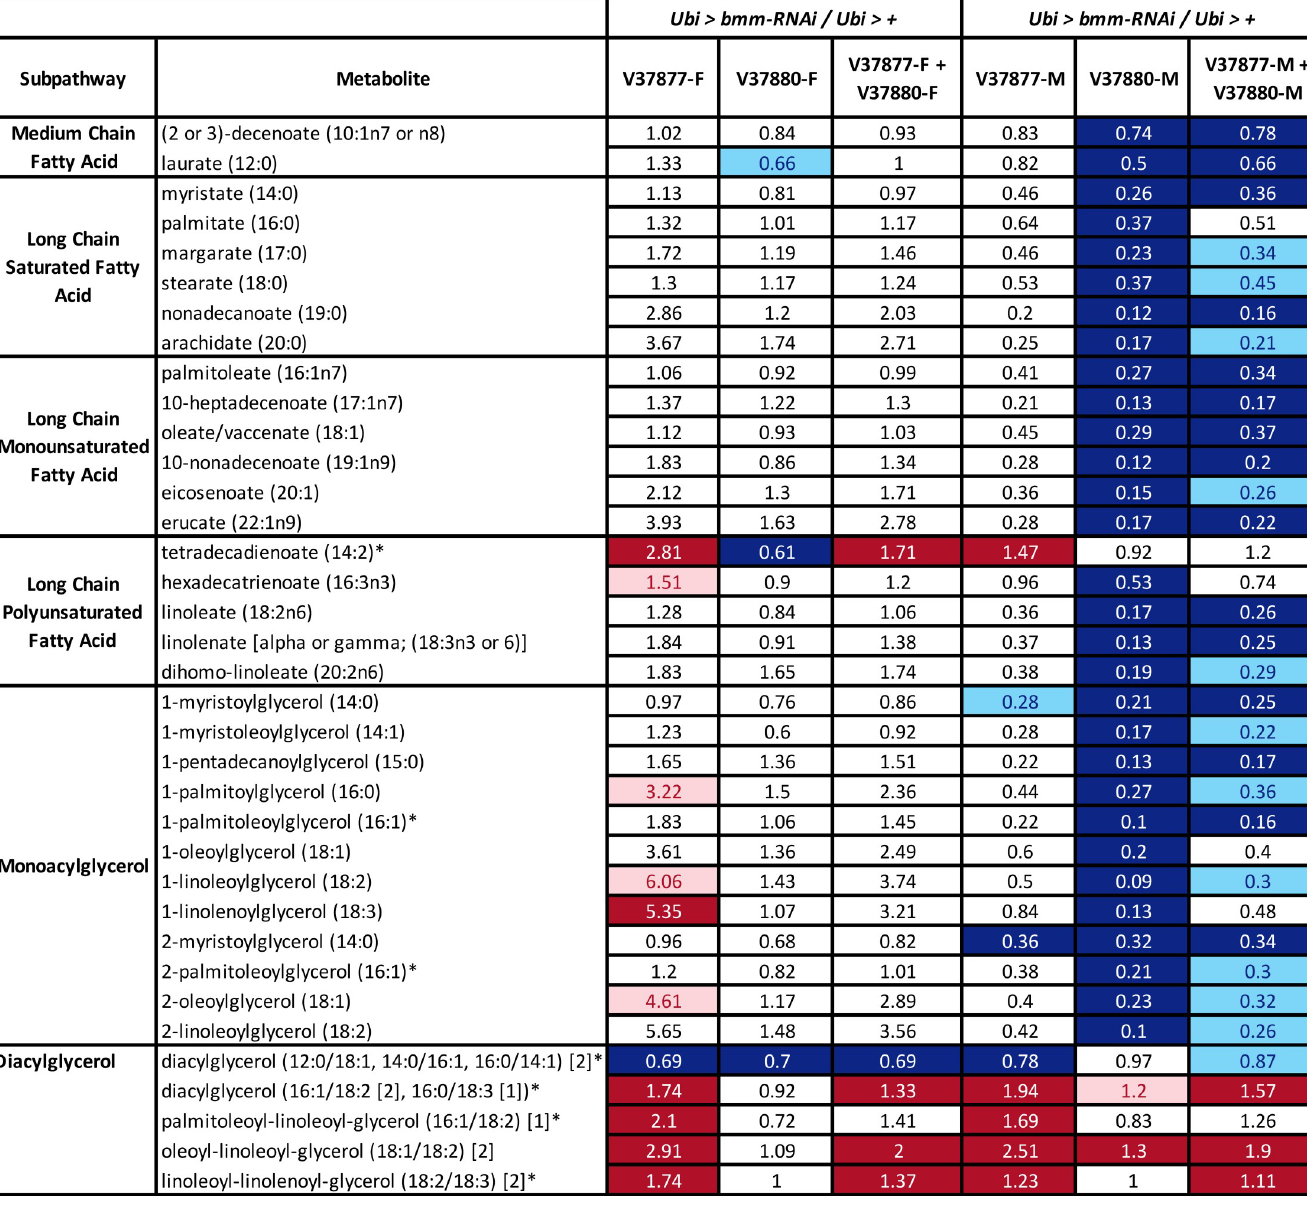
The shifts in energy metabolism described above are accompanied by changes in intermediar- ies of amino acid and peptide metabolism pathways (S6 and S7 Figs, and S2 Dataset). We